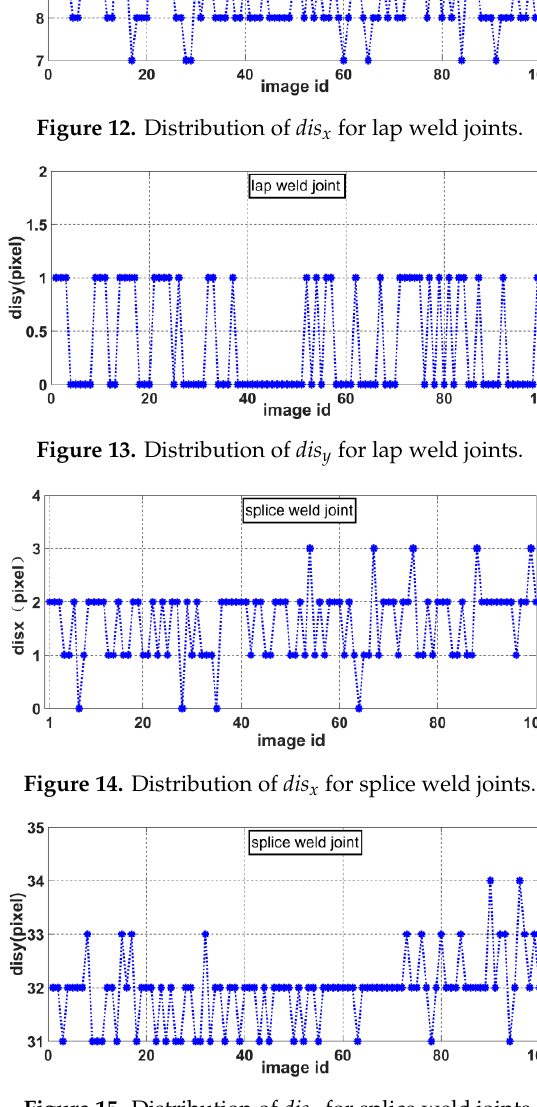
Figure 15. Distribution of dis y for splice weld joints.